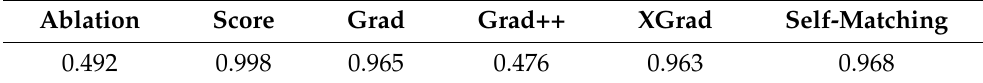
Table 1. Class_drop for occlusion